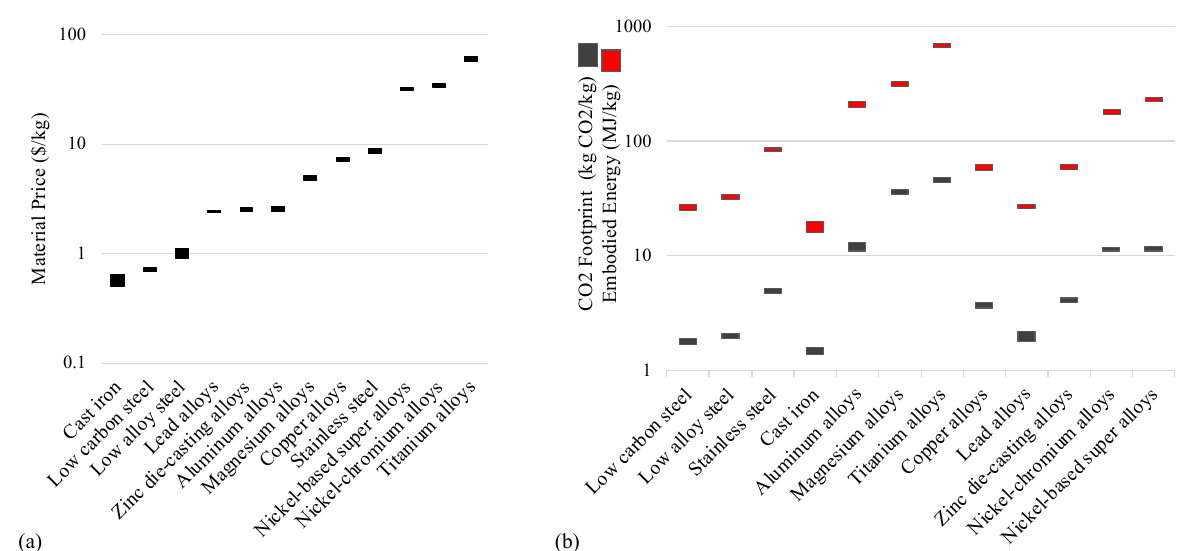
Figure 1. ( a ) Cost of materials based on mass (data taken from Ashby [35]). ( b ) Embodied energy and carbon footprint of various metals (data taken from Ashby [35]).